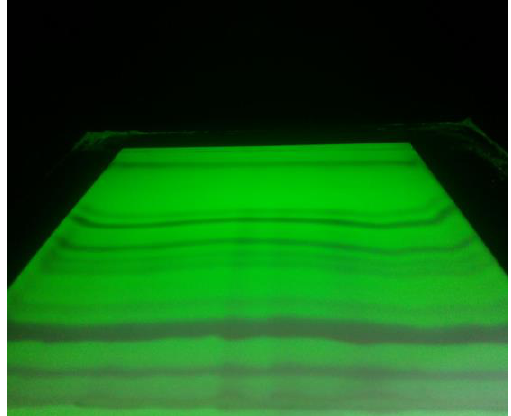
Figure4. Preparative thin-layer chromatography plate for n.b fraction on silica gel GF254